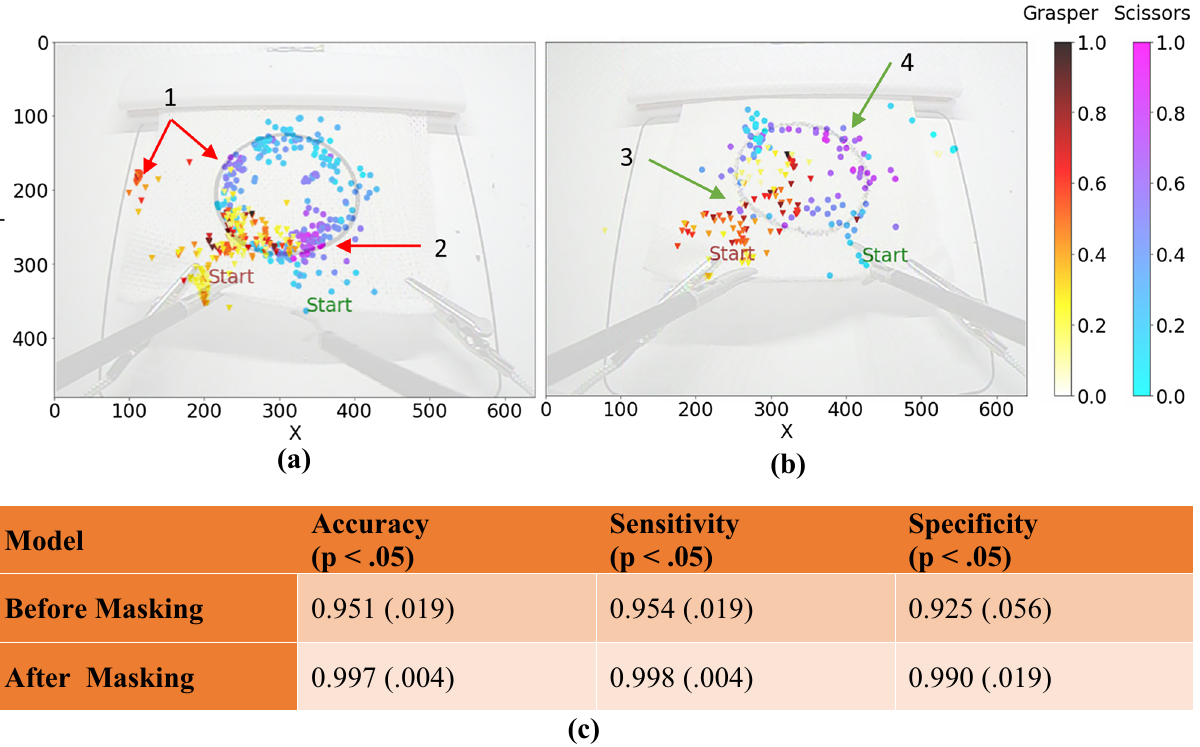
Figure 4. CAM results. CAM plots for (a) a TN (FLS score: 16.8) and (b) a TP (FLS score: 170.7) sample. The plots are presented in the original frame size of 640 × 480. Each dot represents the tool location for a timestamp generated at 1 FPS. This resulted in 256 dots for the TN case as the procedure took 256 s and 105 for TP. The red arrows indicate tool motions that may lead to poor performance, while the green arrows indicate smooth behavior. The color-coded heatmaps illustrate the intensities of the same CAM generated for the given samples. However, different color maps are used for scissors and grasper locations. (c) Overall VBA-Net performance comparison before and after masking. Here, p is the p-value of the statistical analysis, and the numbers within the parentheses in the second and third rows represent standard deviation based on tenfolds of